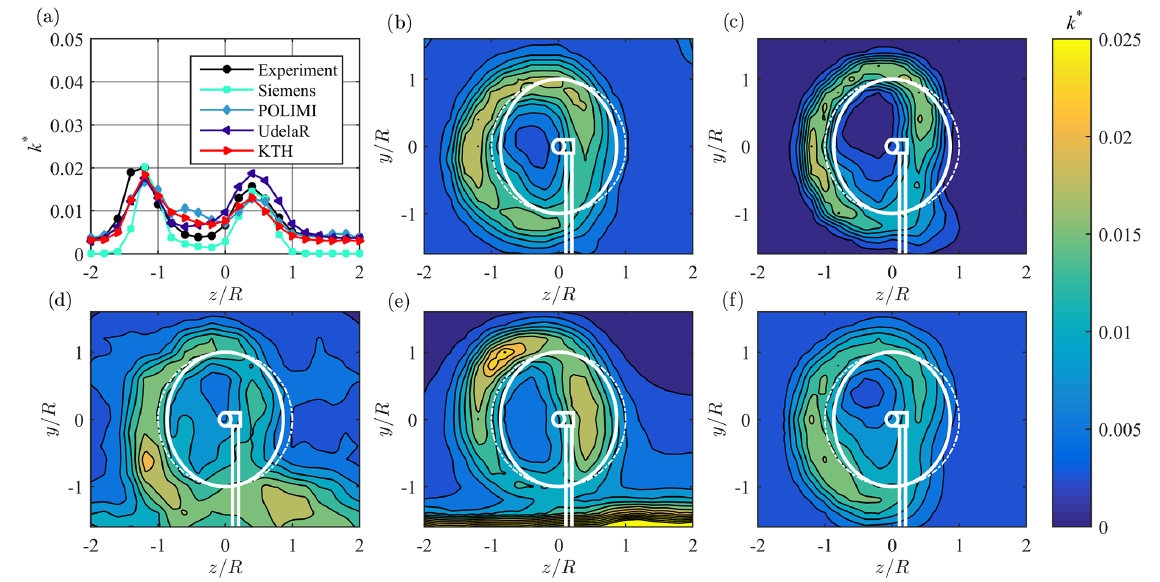
Figure 9. (a) Line plot at hub height and (b–f) contour plots for normalized turbulent kinetic energy (TKE) k ∗ in the wake 3 D behind turbine LARS1, from (b) experiments, (c) Siemens, (d) POLIMI, (e) UdelaR, and (f) KTH. The white lines represent the turbine rotor, nacelle, and tower; solid lines γ = 30 ◦ ; dashed lines γ = 0 ◦